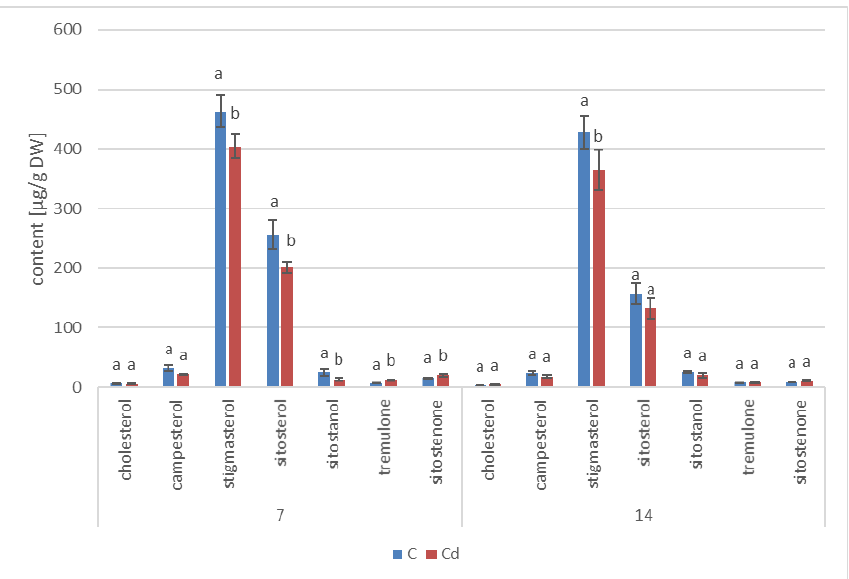
Figure 19. Representative chromatograms of the fractions containing free steroids from diethyl ether extracts obtained from control and cadmium-treated shoots of marigold plants after 14 days of cul- tivation: 1, cholesterol; 2, campesterol; 3, stigmasterol; 4, sitosterol; 5, sitostanol; 6, β - amyrin; 7, α - amyrin; 8, tremulone; 9, sitostenone. T —α -tocopherol.